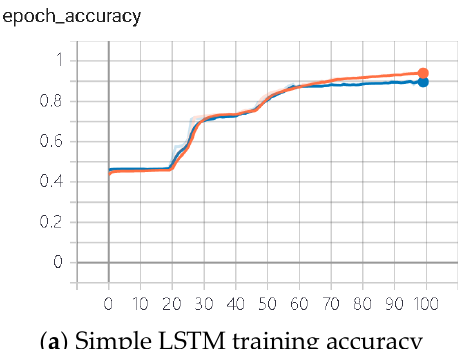
Figure 12. Deep LSTM model confusion matrix diagram.